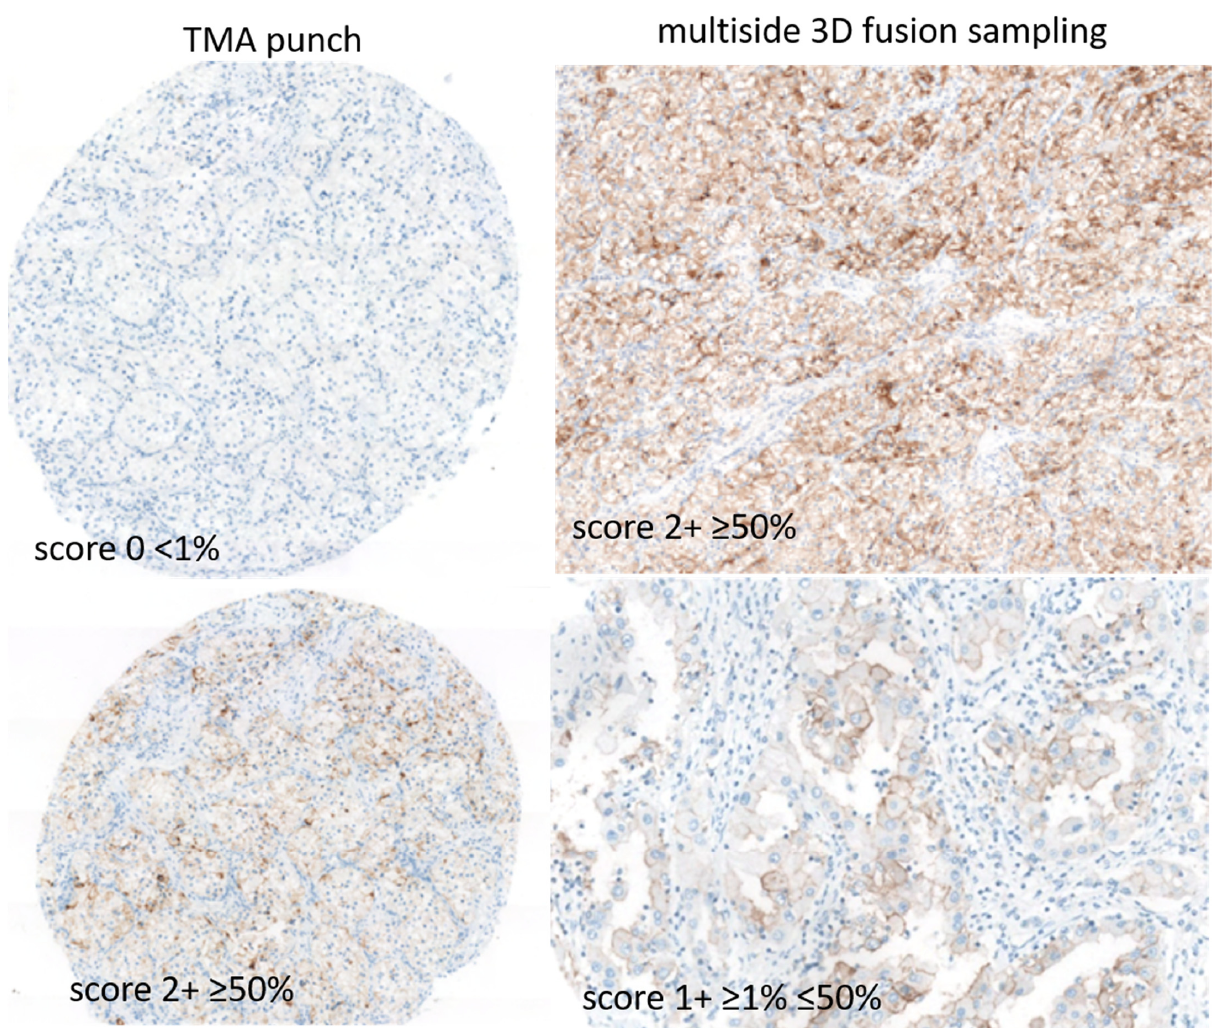
Figure 5. Classification of PD-L1 immune activation in clear cell RCCs after 3D fusion multisite tumor sampling. Diagram showing categorization of immune patterns: score 2 strong expression; score 1, low/weak expression; score 0 with absence of any expression.